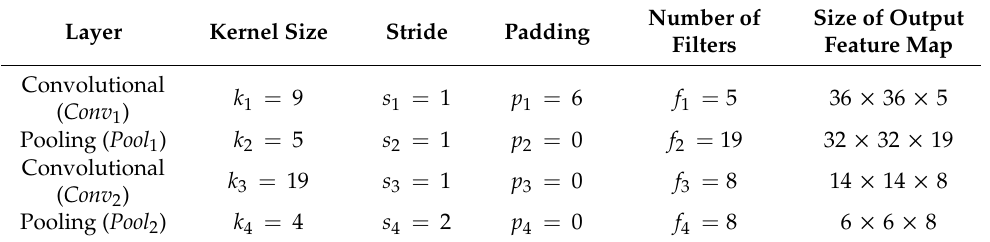
Table 5. The optimal values selected by the ABC algorithm to construct the LeNet-5 topology. Layer Kernel Size Stride Padding